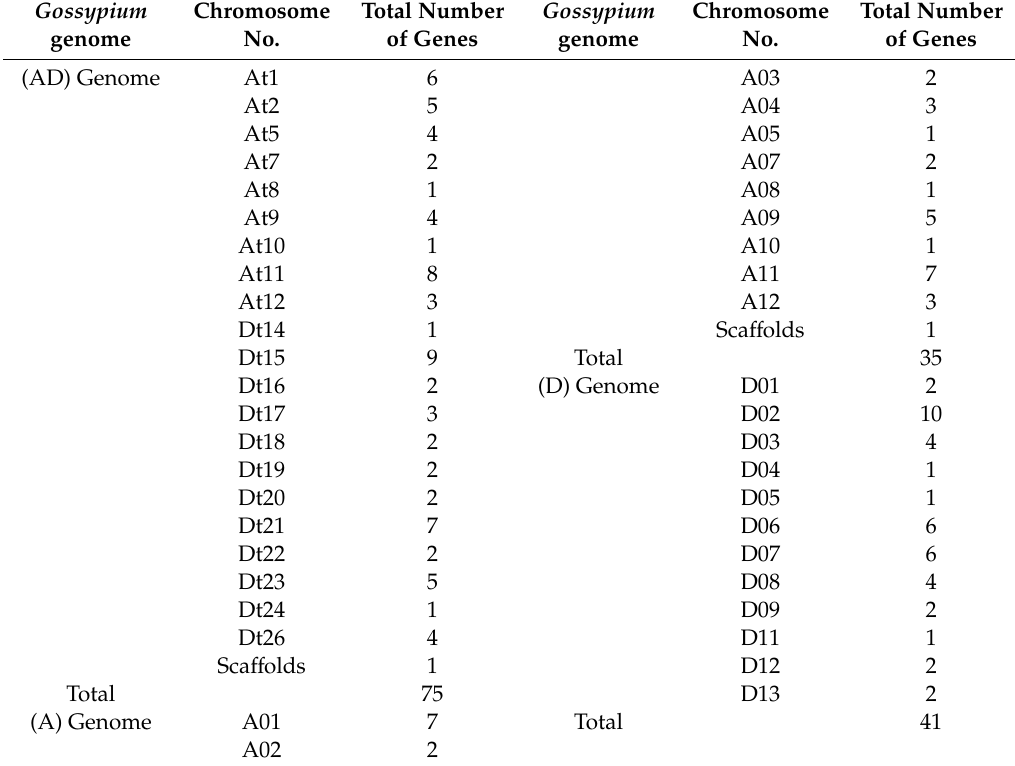
Table 1. Distribution of Pkinase genes among di ff erent chromosomes of G. hirsutum, G. raimondii and G.